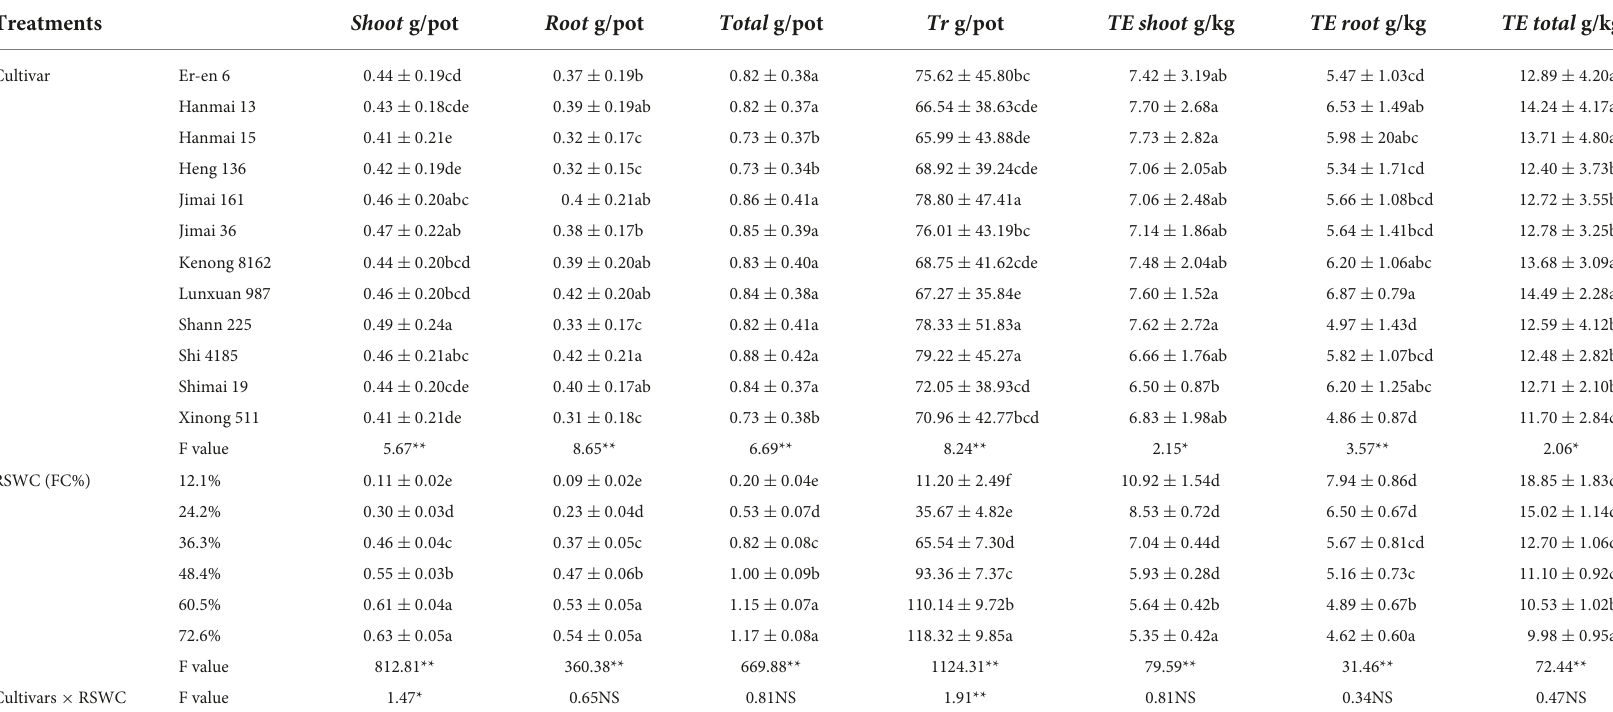
TABLE 1 Main effects of cultivar and SWC on seedling growth ( Shoot , shoot mass; Root , root mass; Total , total biomass), Transpiration ( Tr ), and transpiration efficiency ( TE shoot , TE root , TE total , the ratio of Shoot , Root and Total to Tr ). Treatments